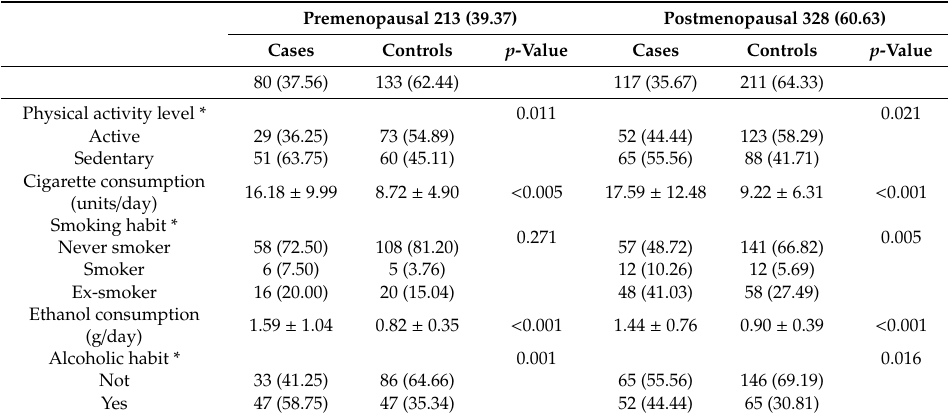
Table 2. Lifestyle characteristics among participants according to menopausal status.